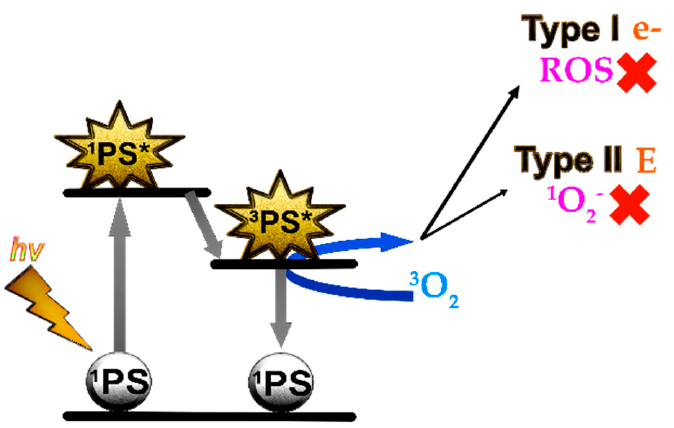
Figure 1. Mechanism of action of antimicrobial photodynamic therapy: photosensitizer